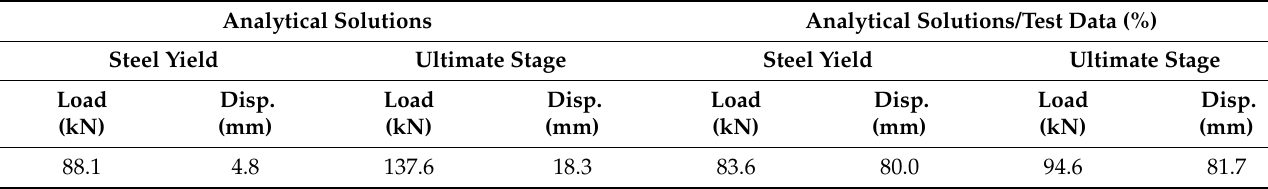
Table 8. Comparison of test data and analytical